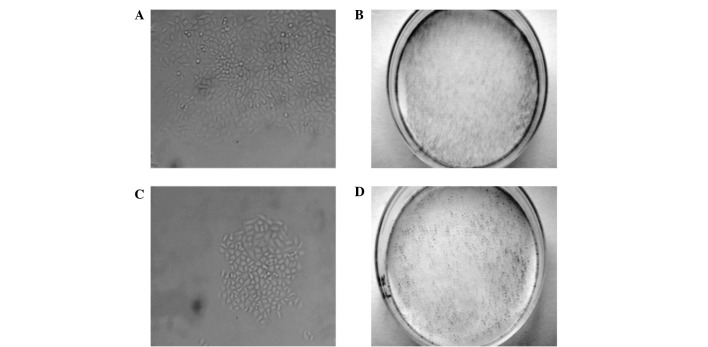
Effects of SNCG-siRNA suppression on the clonogenicity of MCF-7 cells. The colonies formed in (C,D) the SNCG-siRNA-3 line were smaller and fewer than those of (A,B) the parallel control. SNCG, synuclein-γ.